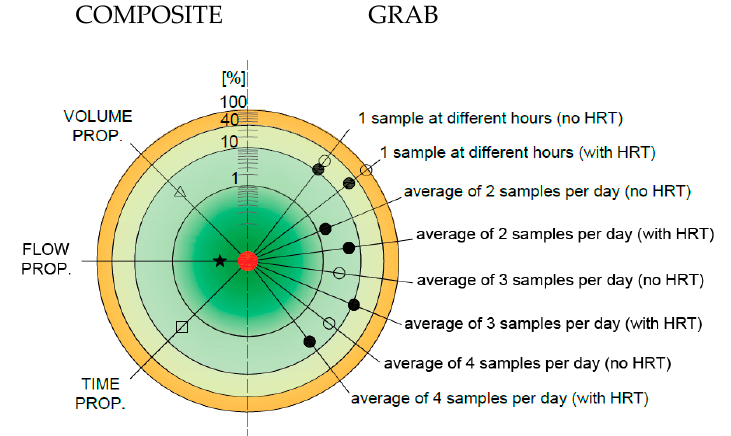
Figure 8. Percentage deviations between ideal removal efficiency for RV_Sub (red dot) and the evaluated removal efficiency found following the different sampling modes, defined in Table 1. Circumferences in the three graphs refer to different values of percentage deviation on a log scale. Full symbols correspond to an overestimation and empty symbols to an underestimation.